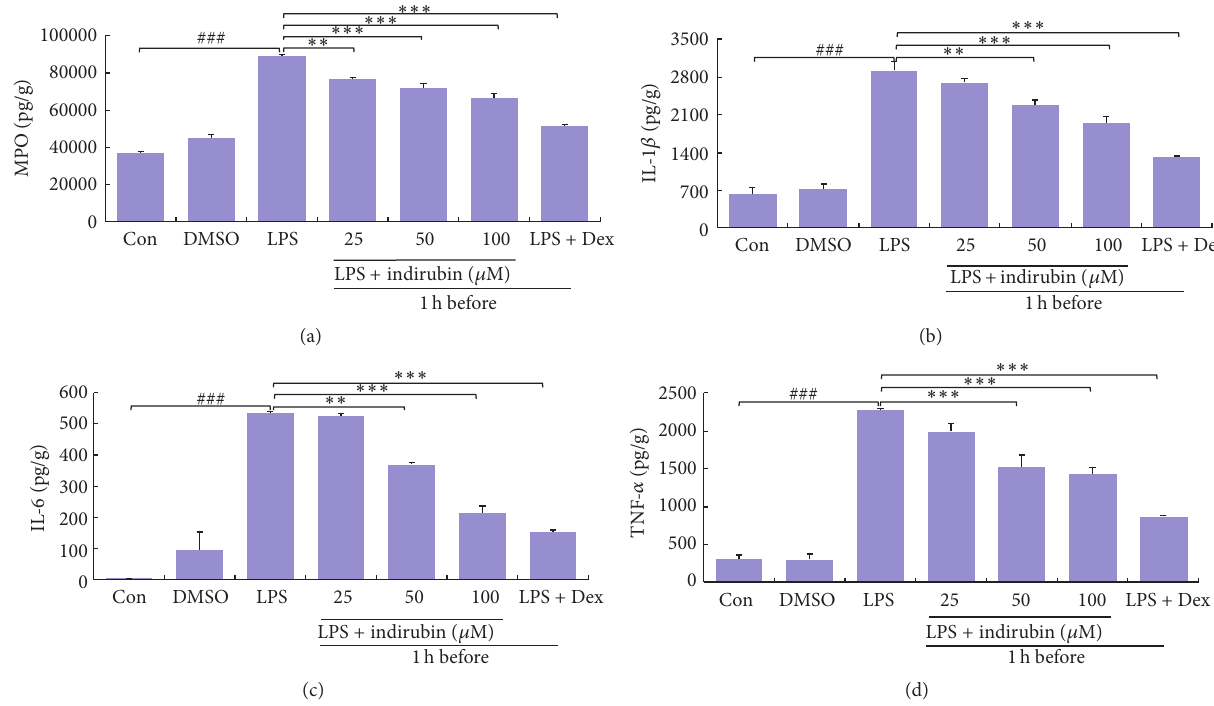
Figure 2: Effect of indirubin on MPO (a), IL-1 𝛽 (b), IL-6 (c), and TNF- 𝛼 (d) in the mammary gland in LPS-stimulated mastitis. Tissue homogenates were used to evaluated MPO (a), IL-1 𝛽 (b), IL-6 (c), and TNF- 𝛼 (d) with ELISA. The values are presented as the means ± SEM of three independent experiments. ### 𝑝 < 0.001 versus control group; ∗∗ 𝑝 < 0.01 and ∗∗∗ 𝑝 < 0.001 versus LPS group.